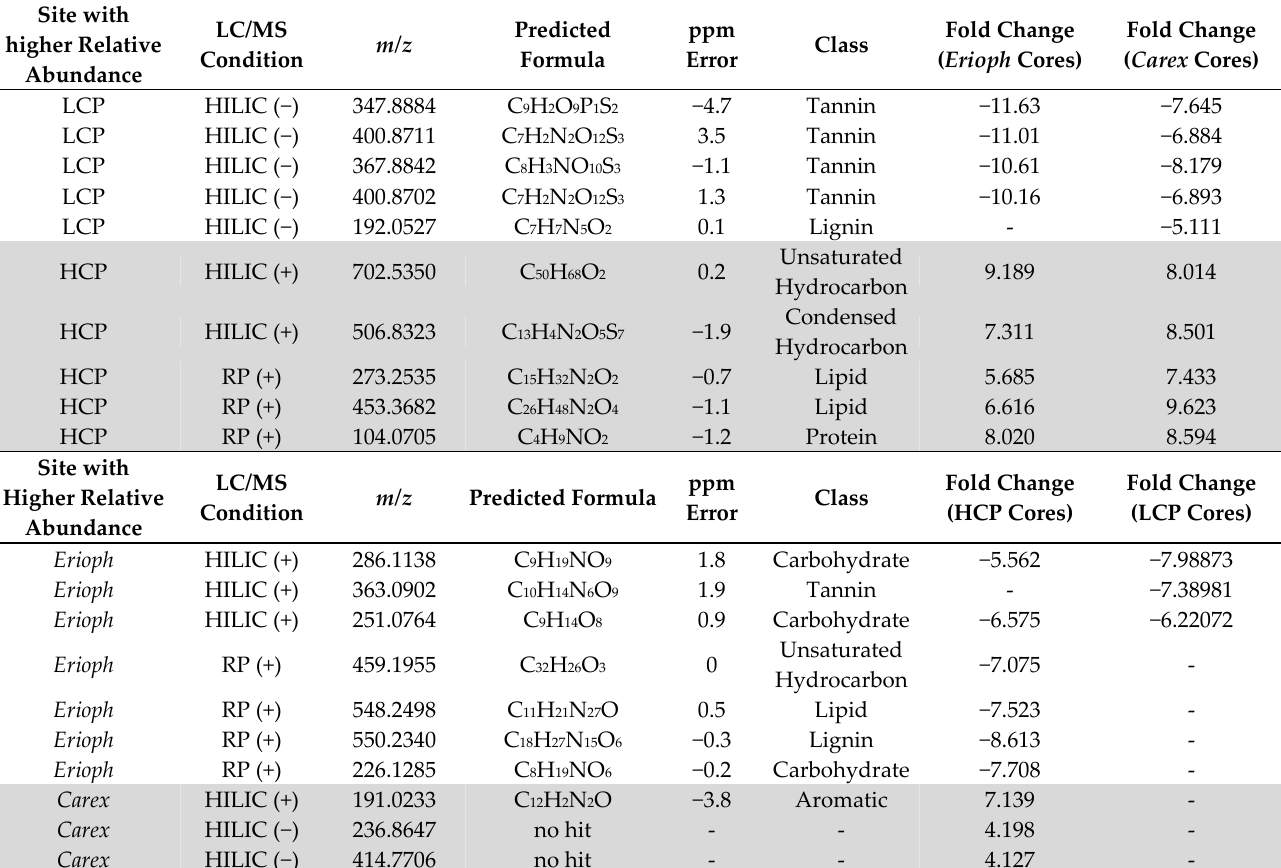
Table 3. Selection of LMW DOM features detected in higher relative abundance at each of the sites.